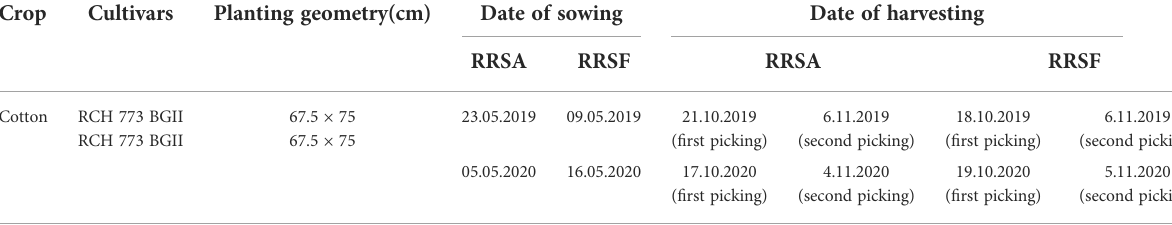
TABLE 4 Details of crop, cultivars, planting geometry, and sowing and harvesting dates. Crop